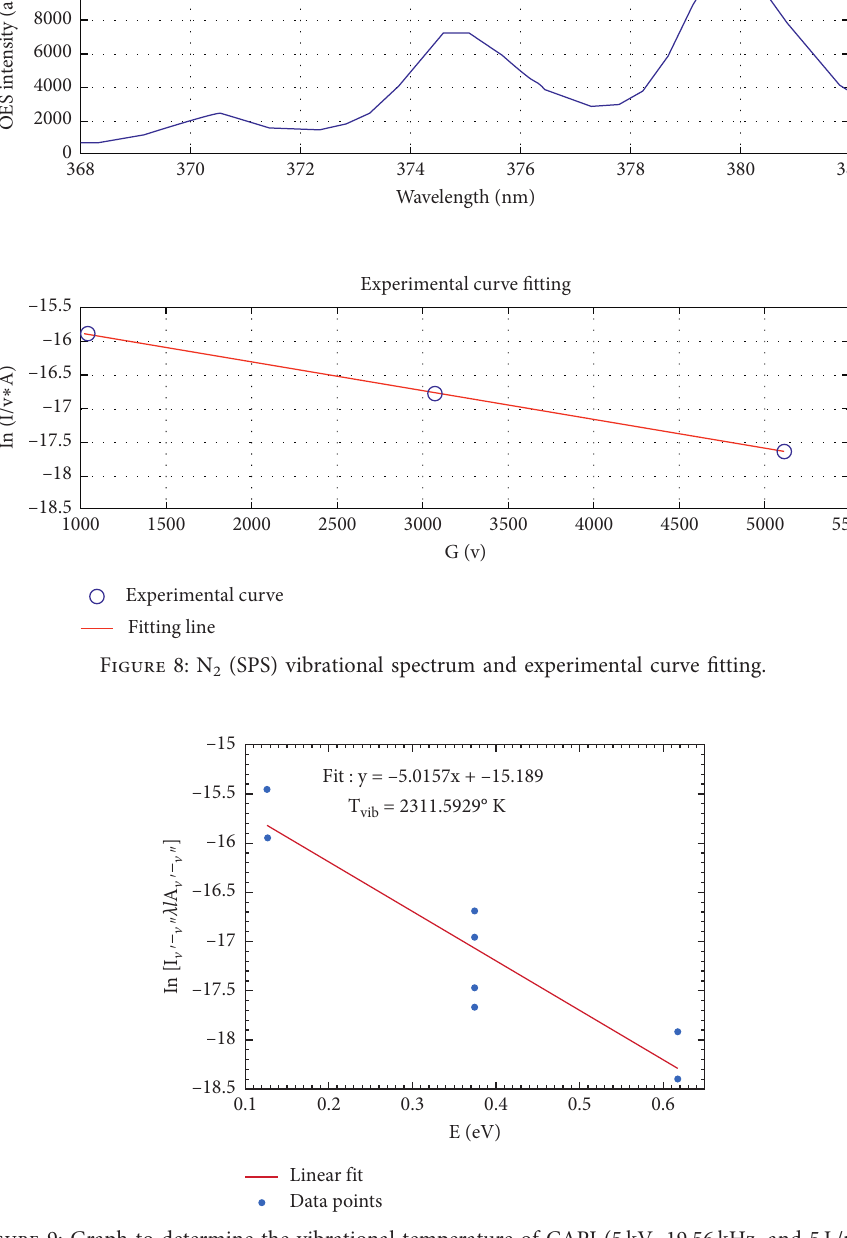
Figure 9: Graph to determine the vibrational temperature of CAPJ (5kV, 19.56kHz, and